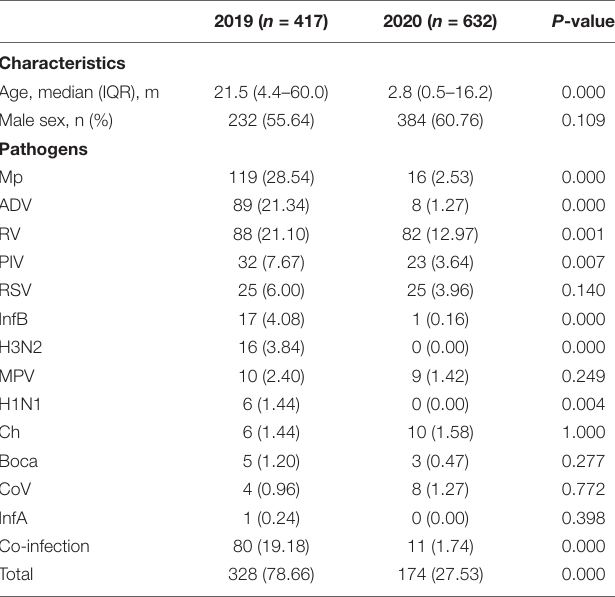
TABLE 1 | Characteristics and incidence of detected respiratory pathogens in hospitalized patients with lower respiratory tract infections (LRTIs) during the